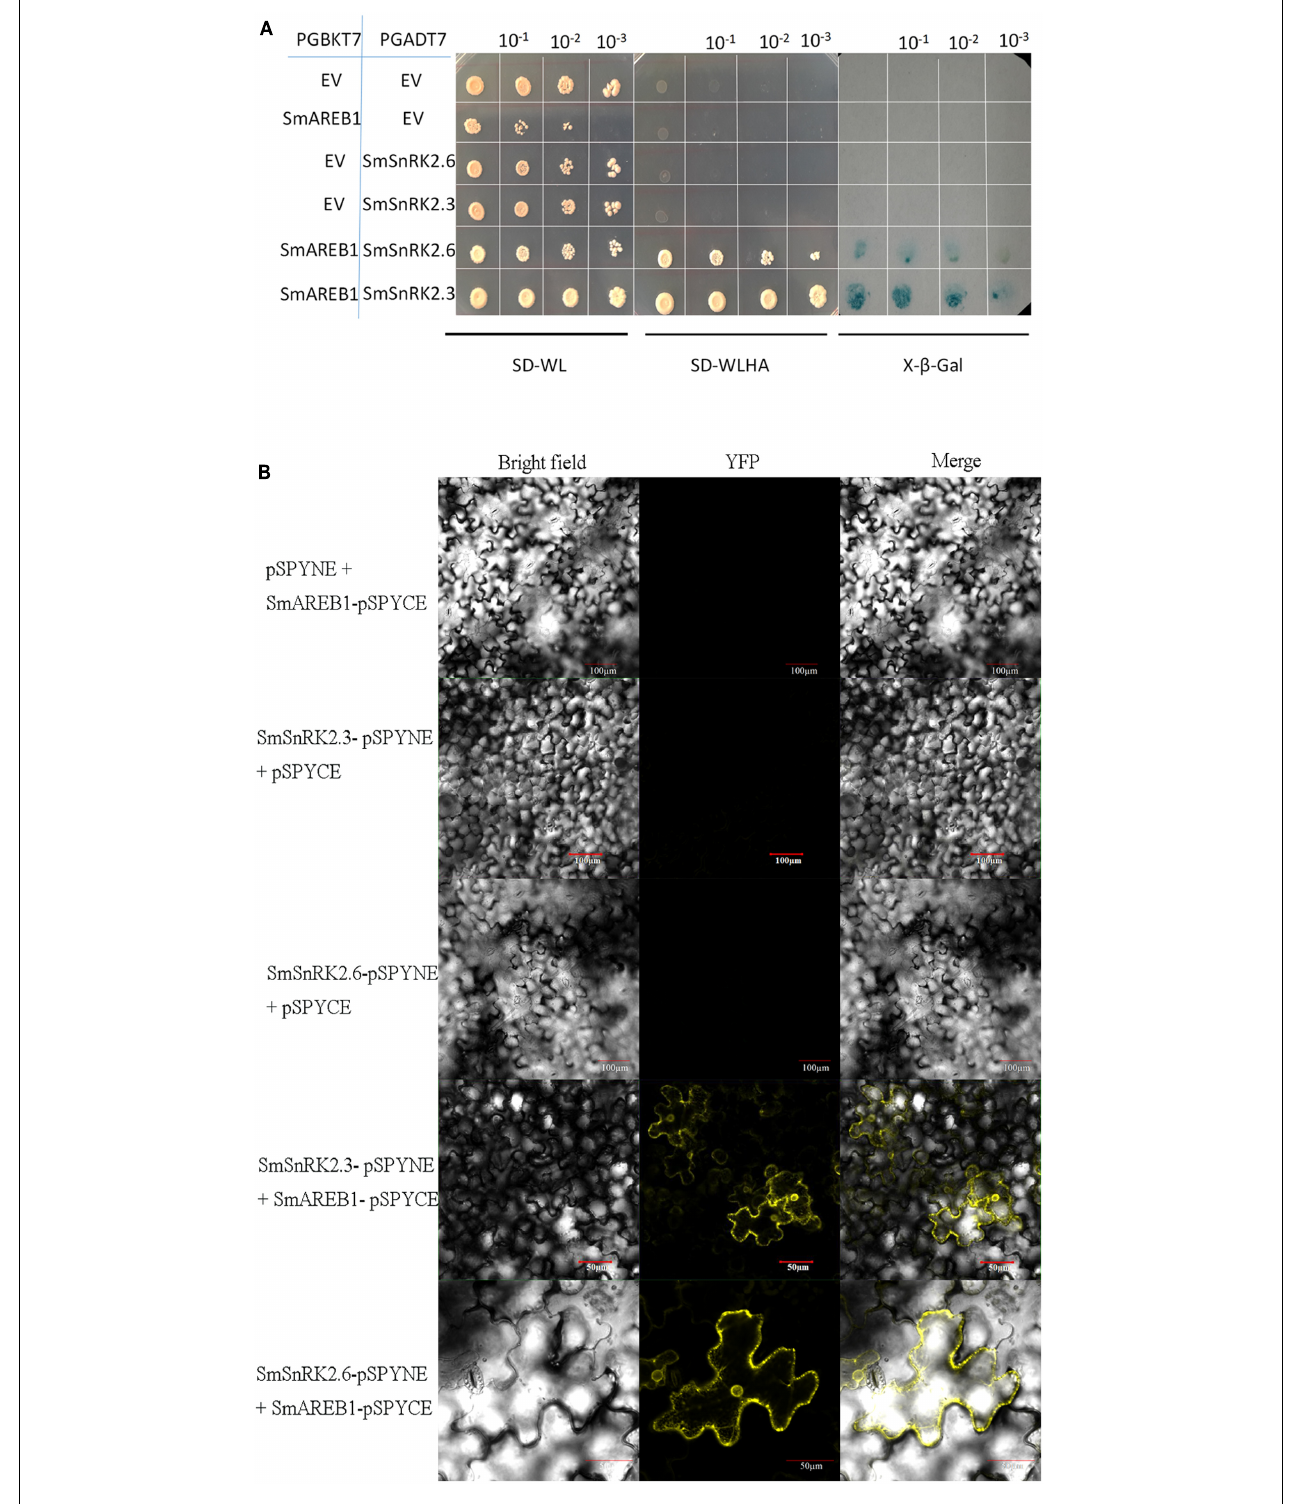
FIGURE 6 | Interaction of SmSnRK2.3/2.6 with SmAREB1. (A) Yeast two-hybrid assay of the interaction between SmSnRK2.3/2.6 and SmAREB1 . AH109 yeast cells harbor the indicated plasmid combinations, which were orderly diluted 10, 100, and 1000-fold, cultured on SD/-Trp-Leu medium and SD/-Trp-Leu-His-Ade medium, and followed by X- β -Gal staining. (B) Bimolecular fluorescence complementation (BiFC) assay of the interactions between SmSnRK2.3/2.6 and SmAREB1 . YFP, yellow fluorescence; Merge, merge of bright field and YFP.